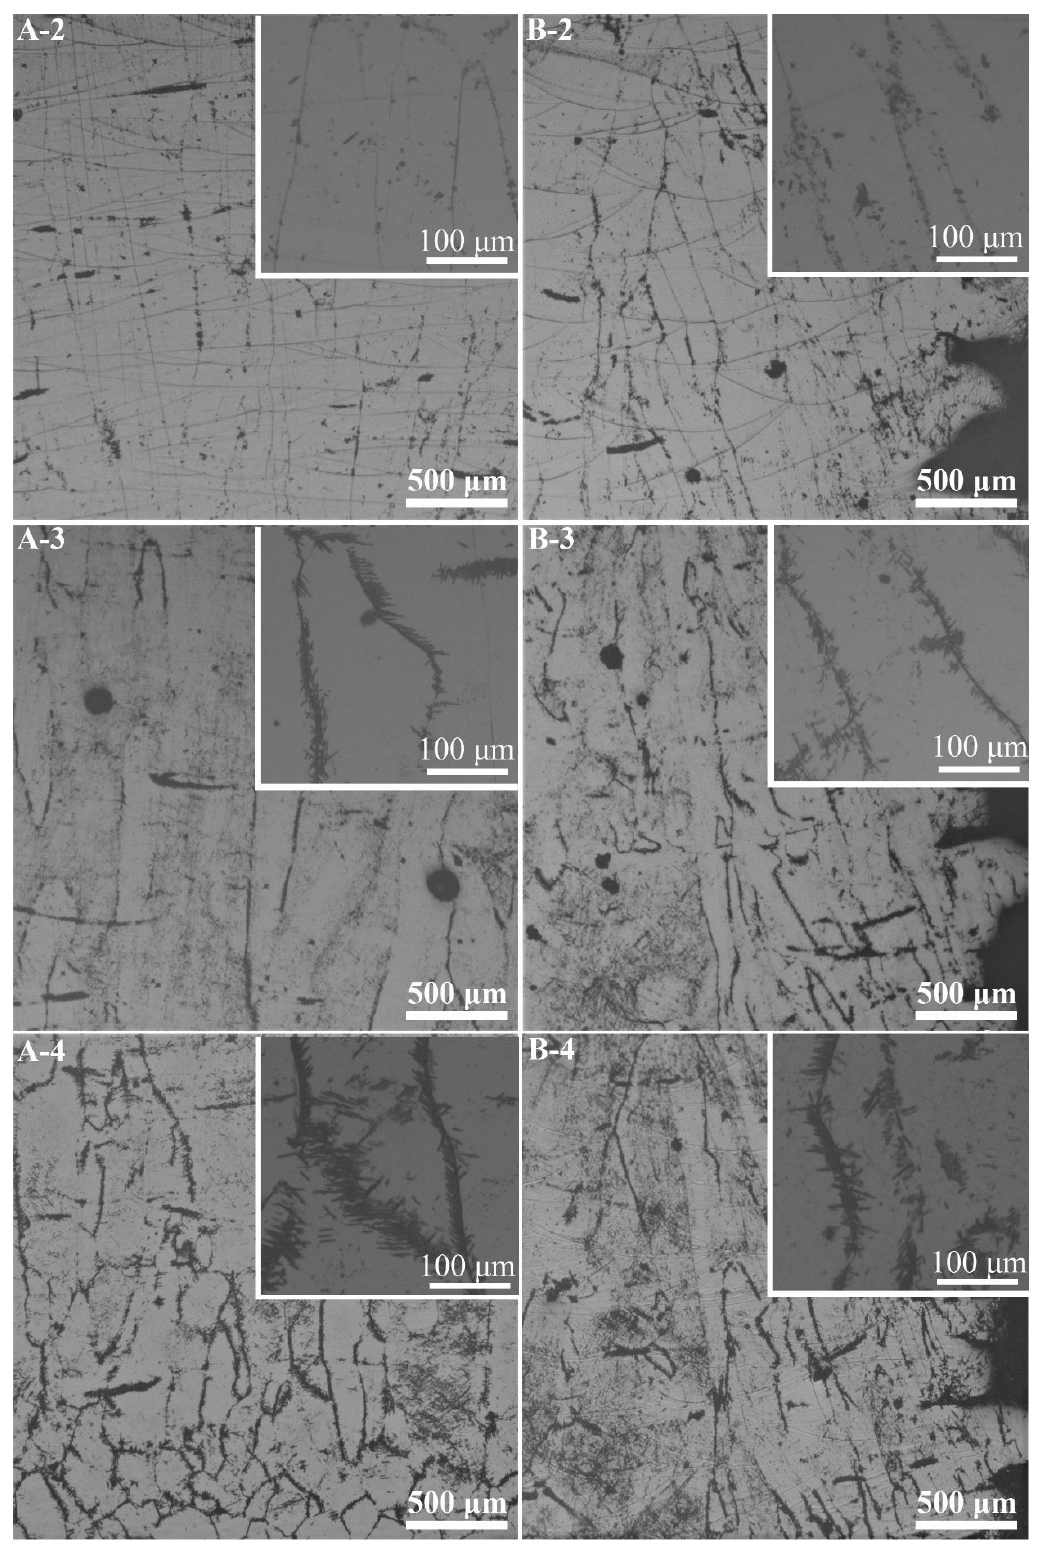
Figure 12. Optical image of vertical section in different segments of sample. (The pictures with the letter (“ A ”) represents the central area of the vertical section, and the pictures with the letter (“ B ”) represents the vertical section of the sample near its surface. Numbers 2–4 on the pictures represent the top, middle, bottom segments on the vertical section, respectively, as shown in Figure 2b.).